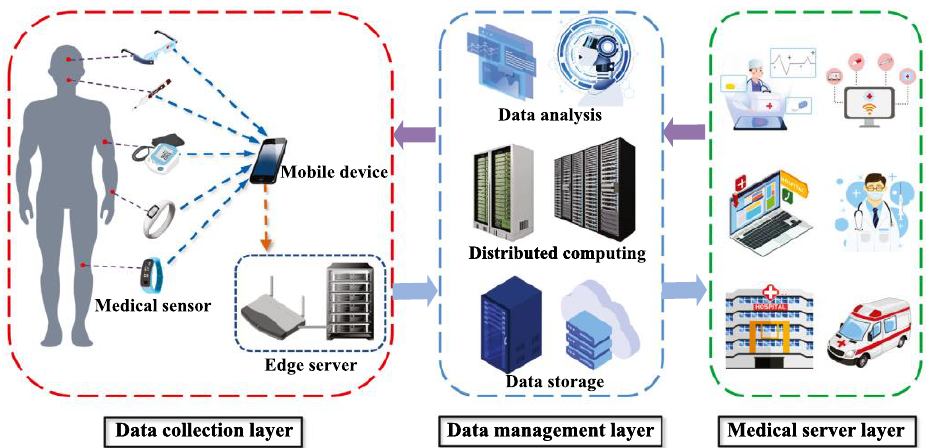
Figure 10. System architecture of the Internet of Medical Things (IoMT) [74]. Reprinted with permission from Ref. [74]. 2021 Association for Computing Machinery.